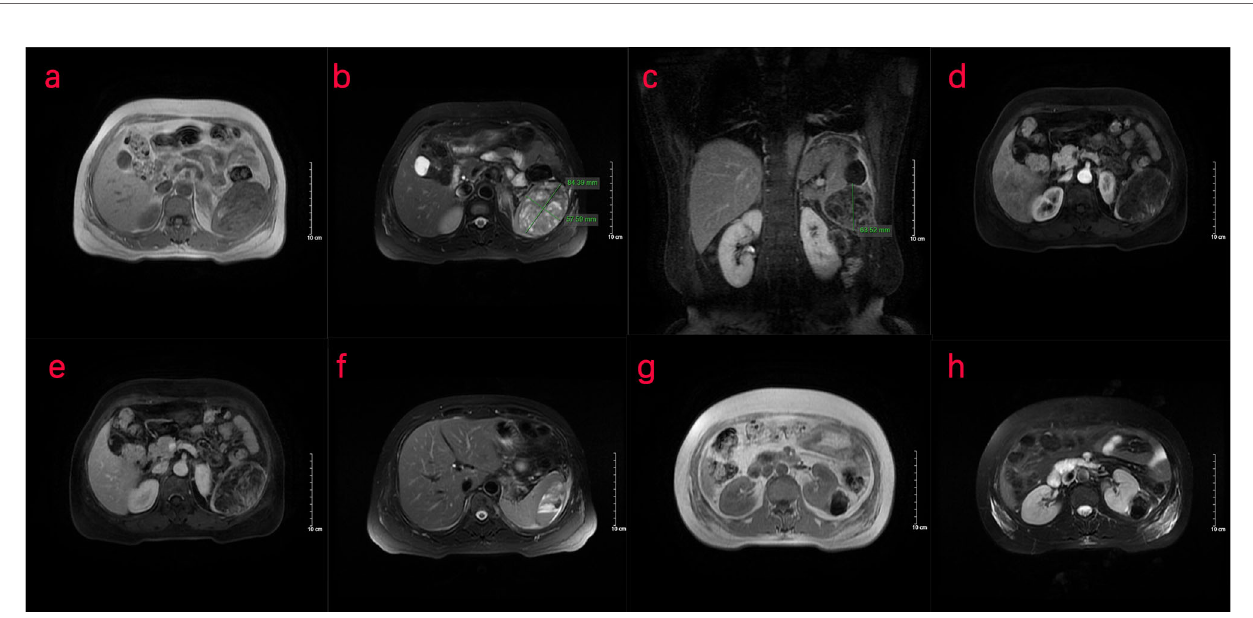
FIGURE 1 | Nuclear MRI examination of the patient. (A – H) MRI of the upper abdomen shows an abnormal signal of the spleen. (A – C) The transverse position of the MRI shows that the spleen is enlarged. A mass occupying shadow, approximately 8.4 cm × 5.7 cm × 6.3 cm in size, is seen in the lower part of the spleen, with clear boundary and a slightly low signal on T1WI and slightly high signal on T2WI. Uneven signal is observed in the spleen, with small cystic cavities and a longer T2 signal. (D, E) MRI shows progressive enhancement patterns. (F) Spindle-shaped abnormal signal can be seen under the capsule of the spleen above the lesion, with a smooth edge, septa inside, mixed signals, and fl uid – fl uid level in the chamber, indicative of a hematoma under the capsule of the spleen. (G, H) A nodular T1/T2 hypointense shadow, approximately 3.3 cm × 3.6 cm in size, was seen in the lower part of the lesion compressing the left kidney nearby. T1WI, T1-weighted imaging; T2WI, T2-weighted imaging.